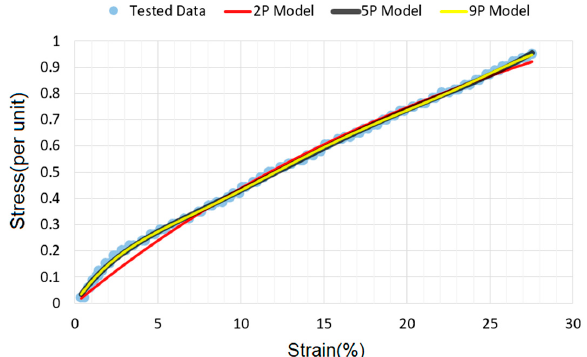
Figure 3. The tested data (blue dots) are from a uniaxial tensile test of an liquid silicone rubber (hereafter LSR) specimen in a dumbbell shape by the method in [26]; the red, black, and yellow lines represent the fitted curves based on the Mooney-Rivlin (hereafter MR) model of 2P, 5P, and